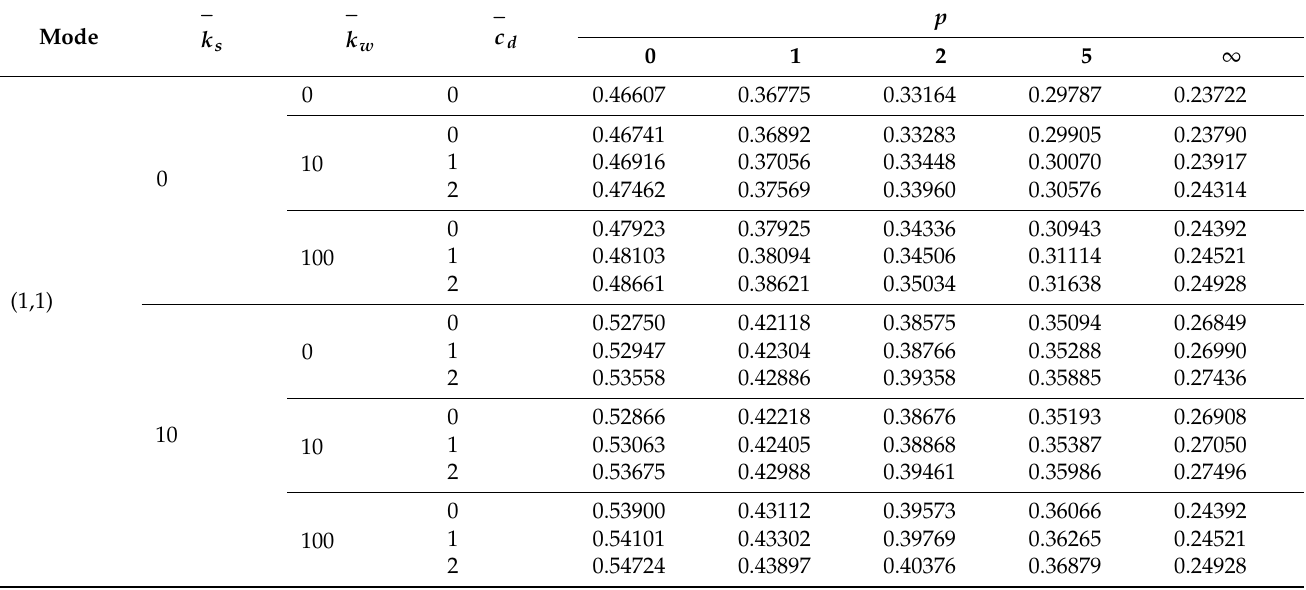
Table 17. Non-dimensional fundamental frequencies (cid:101) ω = ω h plates ( h / a = 0.2, b / a = 0.5).